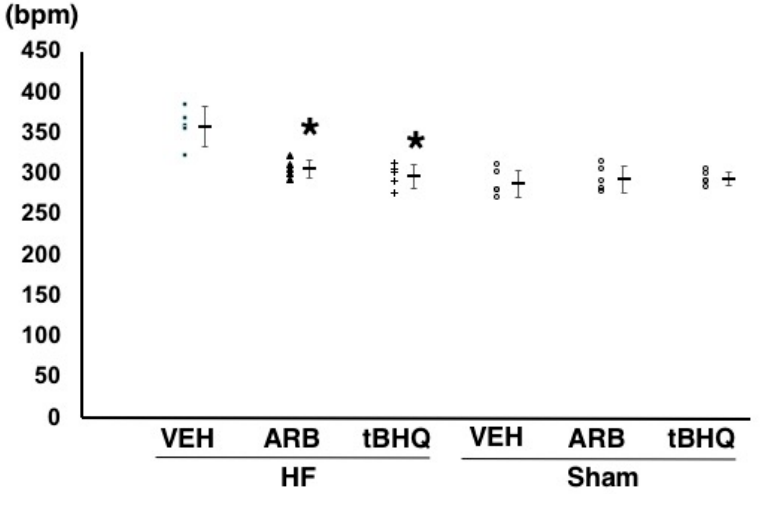
Figure 2. Heart rate of heart failure treated with intracerebroventricular (ICV) infusion of vehicle (HF-VEH), or with ICV infusion of angiotensin II type 1 receptor blocker (HF-ARB), or with ICV infusion of nuclear factor erythroid 2-related factor 2 activator, tert -butylhydroquinone (HF-tBHQ), or sham treated with ICV infusion of VEH, or with ICV infusion of ARB, or with ICV infusion of tBHQ. n = 5 for each group. All data are shown in dot plot and mean ± standard deviation. * p < 0.05 vs. HF-VEH in HF-ARB and HF-tBHQ. Bpm = beats per minute.